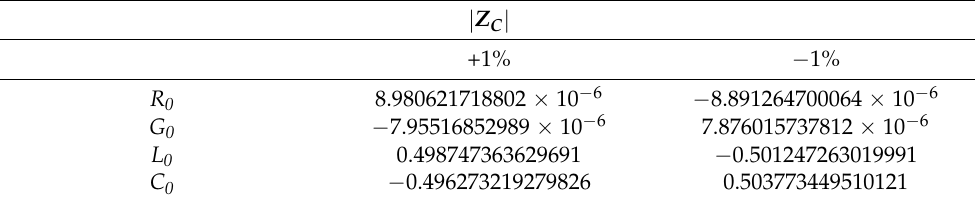
Table 1. Changes to the wave impedance modulus.